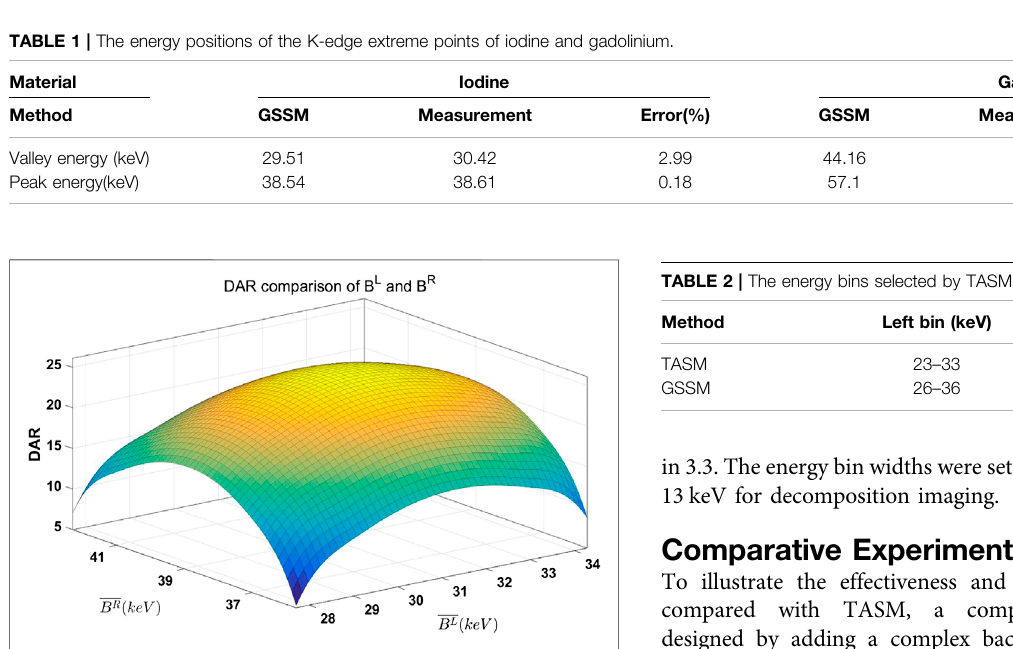
FIGURE 7 | DAR comparison of B L and B R under 10 keV energy bin width, and B L and B R represent the mid-values of B L and B R .